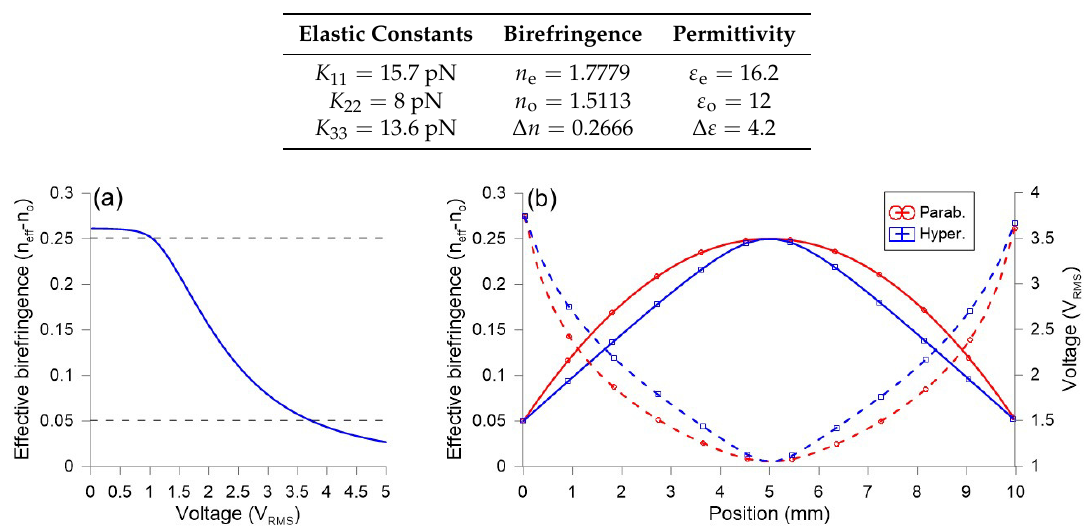
Figure 9. ( a ) Simulation of the effective birefringence as a function of voltage. ( b ) Parabolic and hyperbolic phase profiles (solid lines) and the required voltages (dashed lines) to obtain these